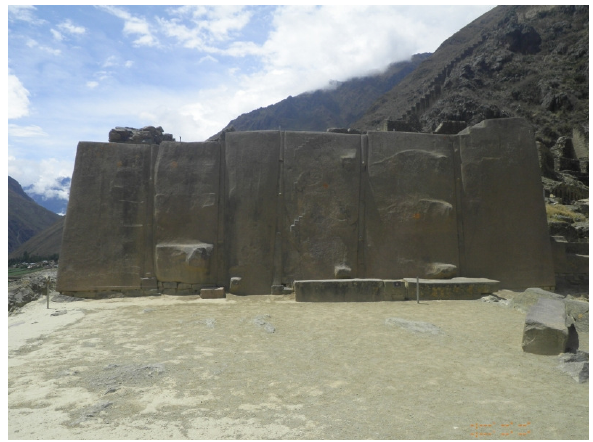
Figure 2: Wall of the six monoliths also known Temple of the Sun